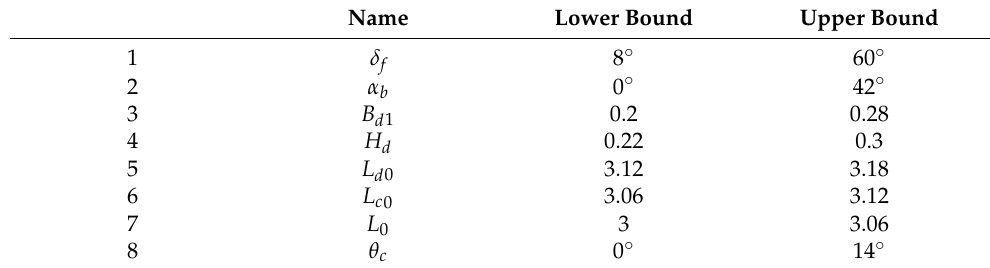
Table 7. Boundaries of design variables used for sample generation.